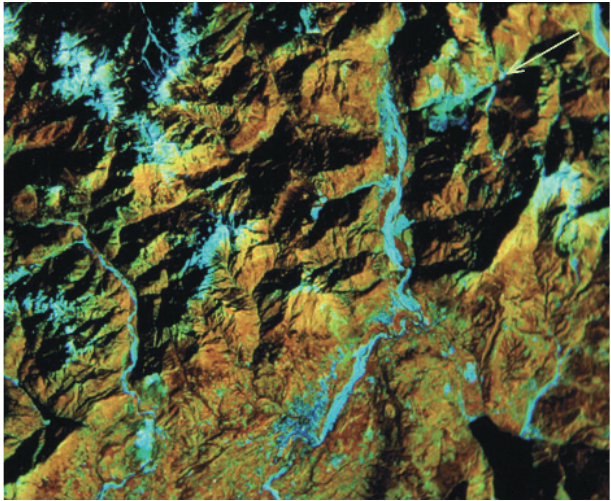
Figure 1. Satellite image of the Vaiont Valley, and the tributary torrent of the Piave River Basin.